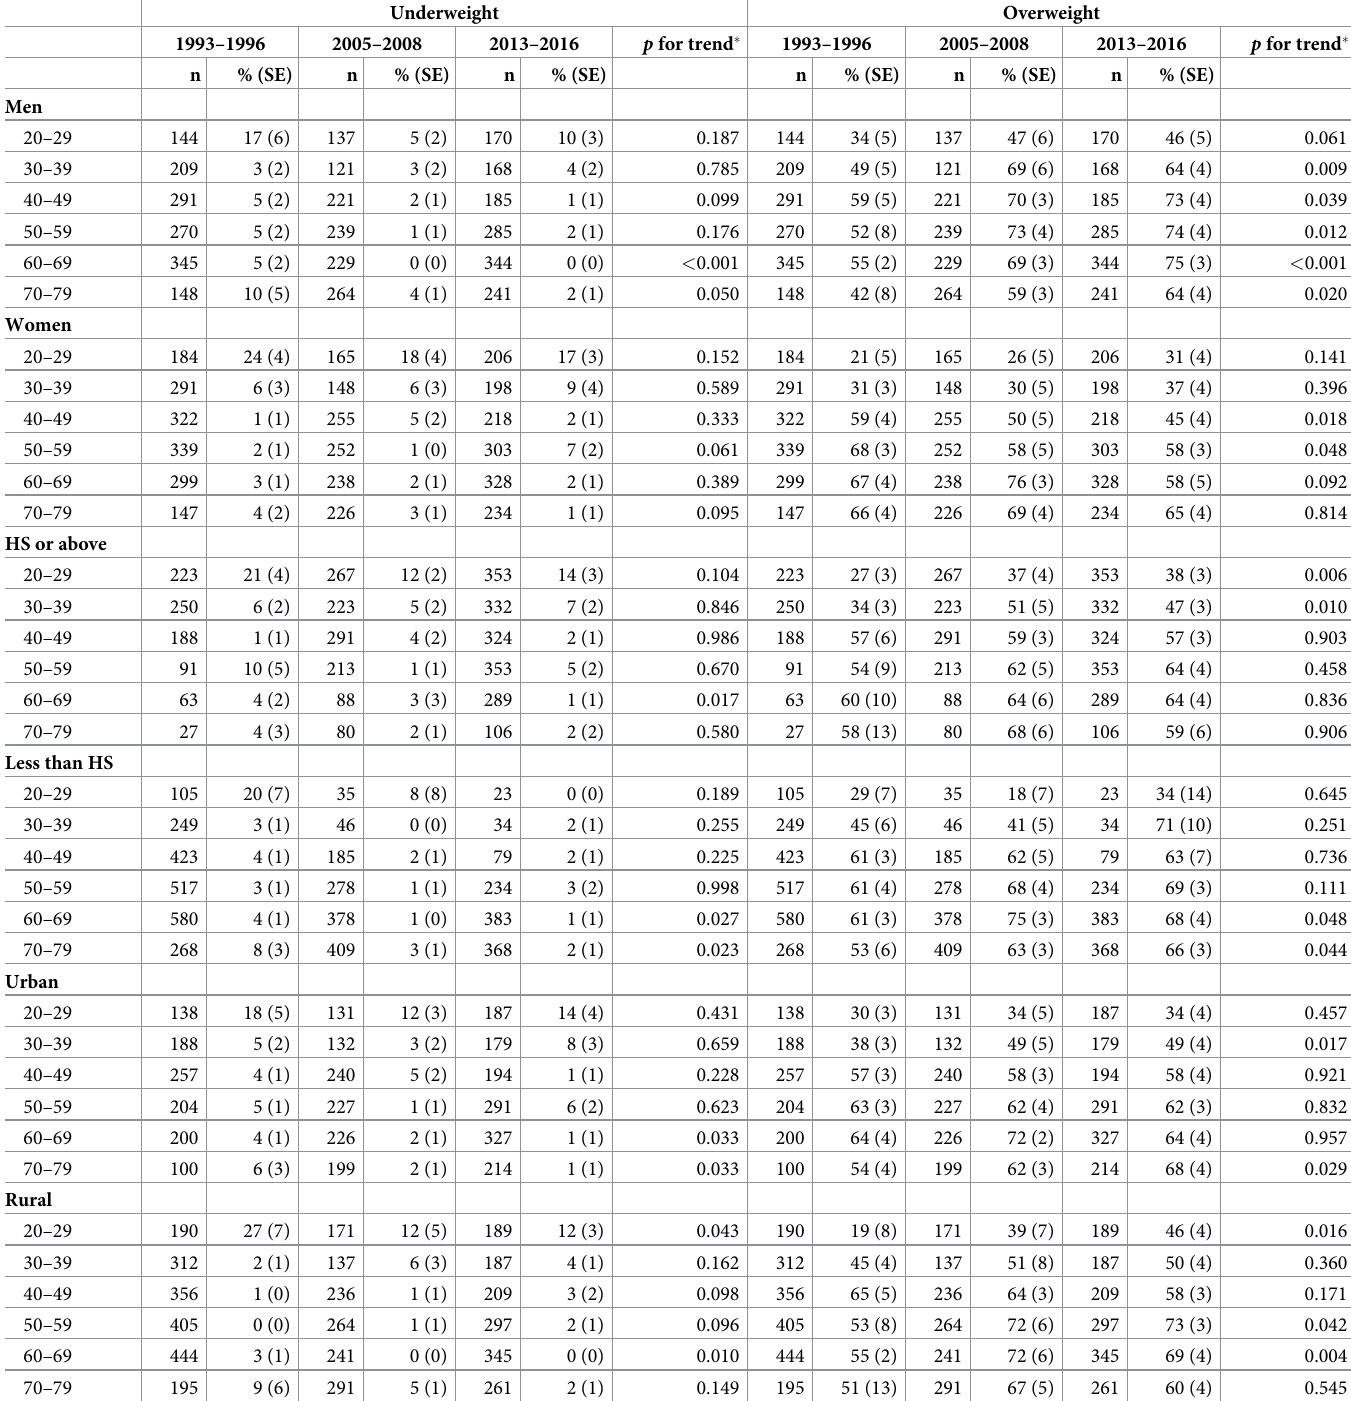
Table 3. Trends in prevalence of underweight and overweight among Taiwanese adults: the NAHSIT